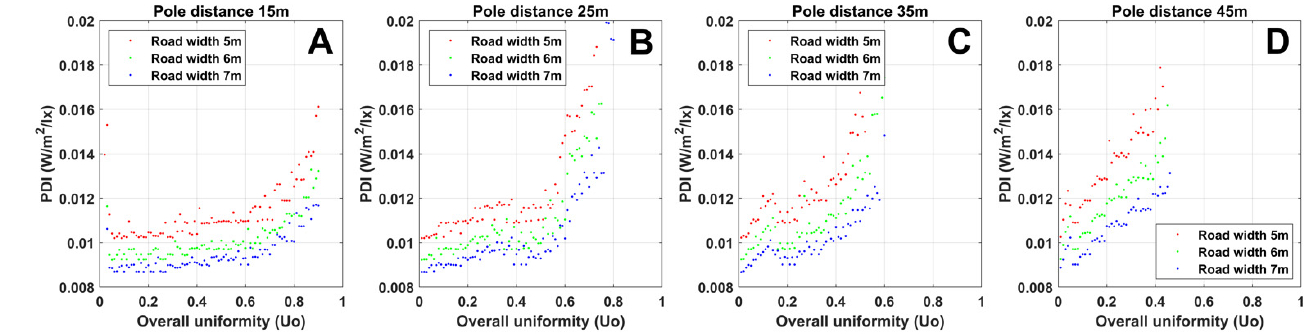
Figure 7. Overall uniformity of illuminance vs. pole distance vs. minimum PDI The PDI was presented on a color scale. The dark blue color indicates a low PDI, whereas yellowish colors refer to higher PDI levels. The white space equals a lack of technical solutions: ( A ) results for road width of 5 m; ( B ) results for road width of 6 m; ( C ) results for road width of 7 m.